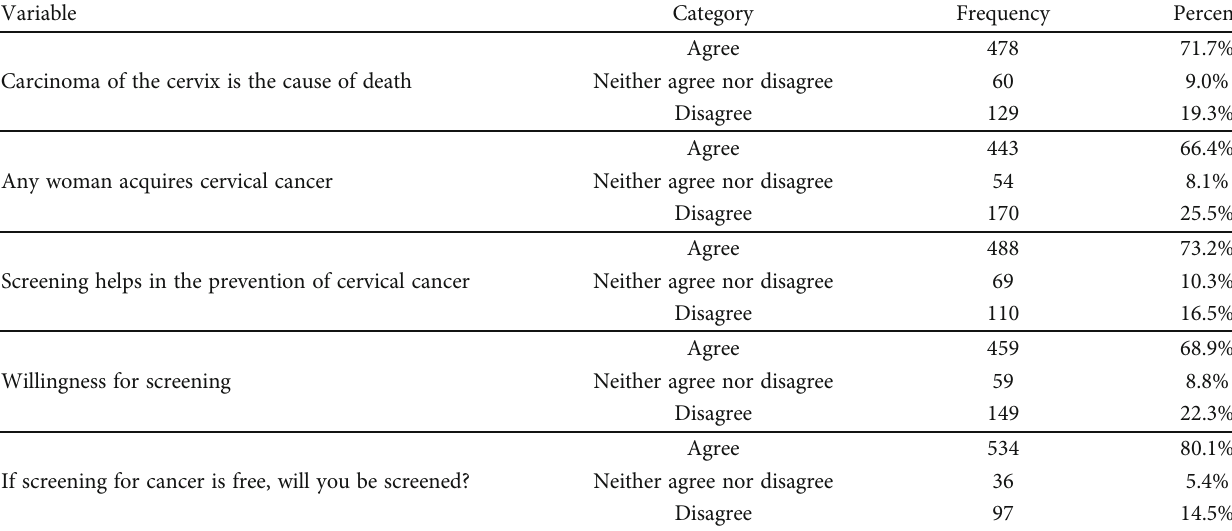
Table 6: Respondents ’ attitudes towards cervical cancer screening at Adama Science and Technology University, Adama, Ethiopia, May 2014.